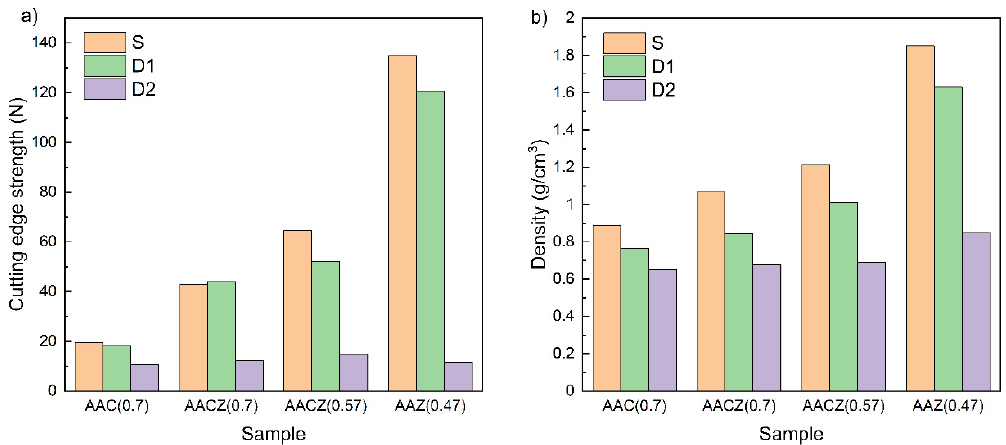
Figure 8. Cutting edge strength ( a ) and density ( b ) of AAC (0.7), AACZ (0.7), AACZ (0.57) and AAZ (0.47) samples.